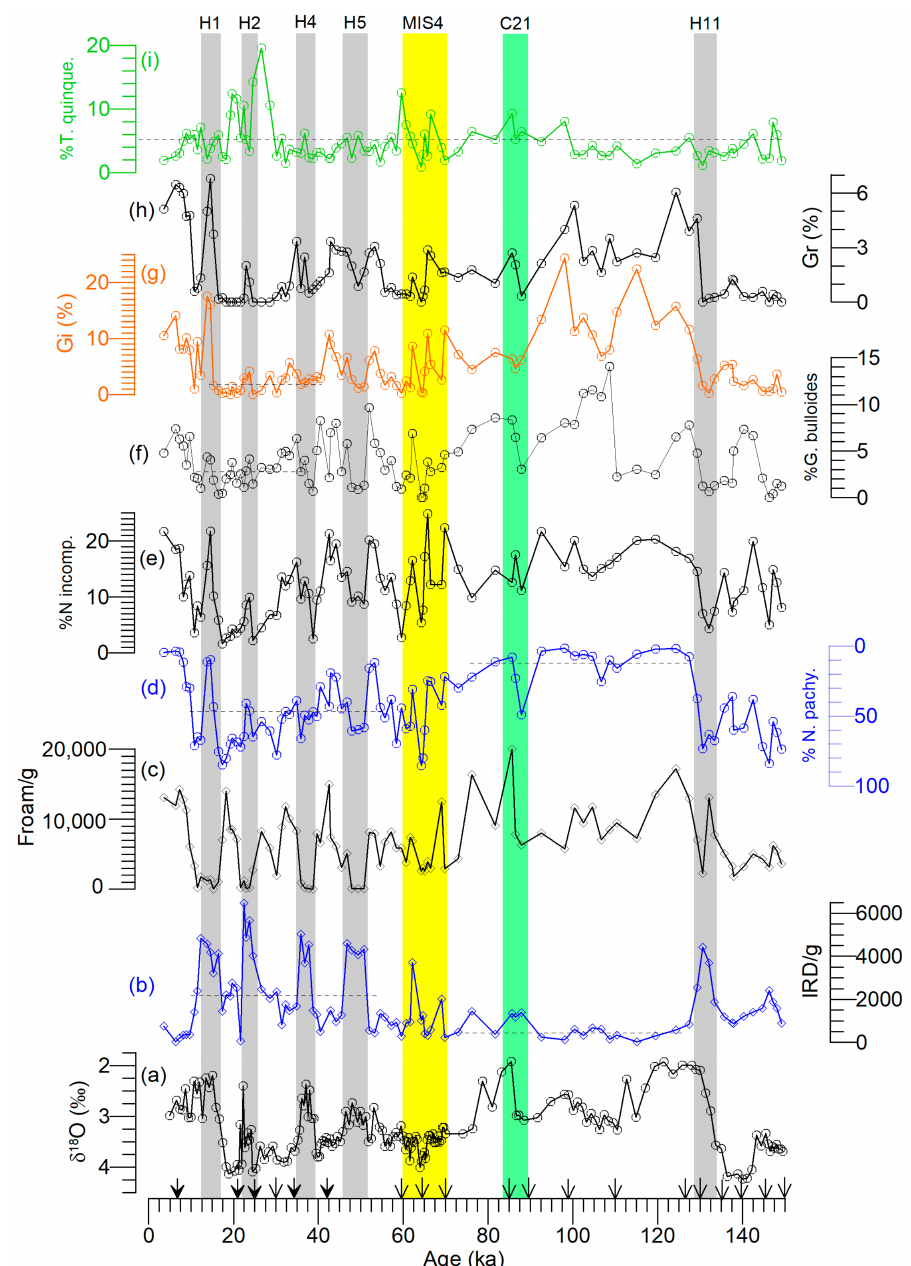
Figure 5. ( a ) δ 18 O in N. pachyderma and the concentration of ( b ) ice-rafted detritus (IRD/g) and ( c ) planktonic foraminifera (Foram/g) per gram of dry sediments in core Hu90-08 (this study). The percentage of six dominant foraminifera is plotted as shown from ( d – i ). Note the y -axis for % N. pachyderma is reversed (see detailed text). Downward filled-headed arrows represent the 14 C-AMS dates used to construct the stratigraphy between 6.34 and 42.90 ka, whereas the simple-headed arrows show the tie points as illustrated in Figure 3. Note the yellow bar represents the MIS4. Hx = Heinrich events; Cx = Cooling